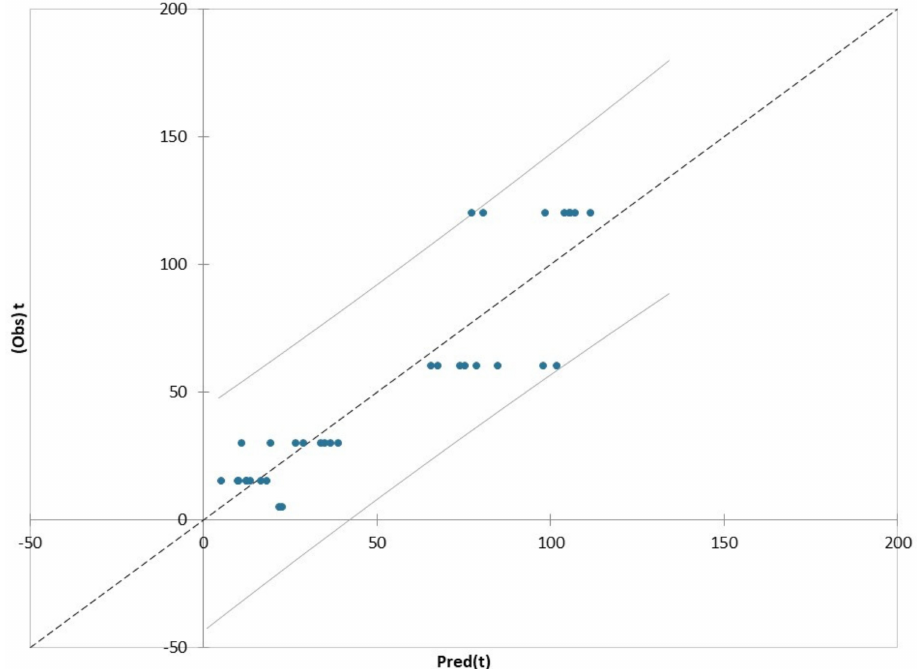
Figure 4. PLS regression between predicted and observed values on t (time) variable with confidence intervals using the complete